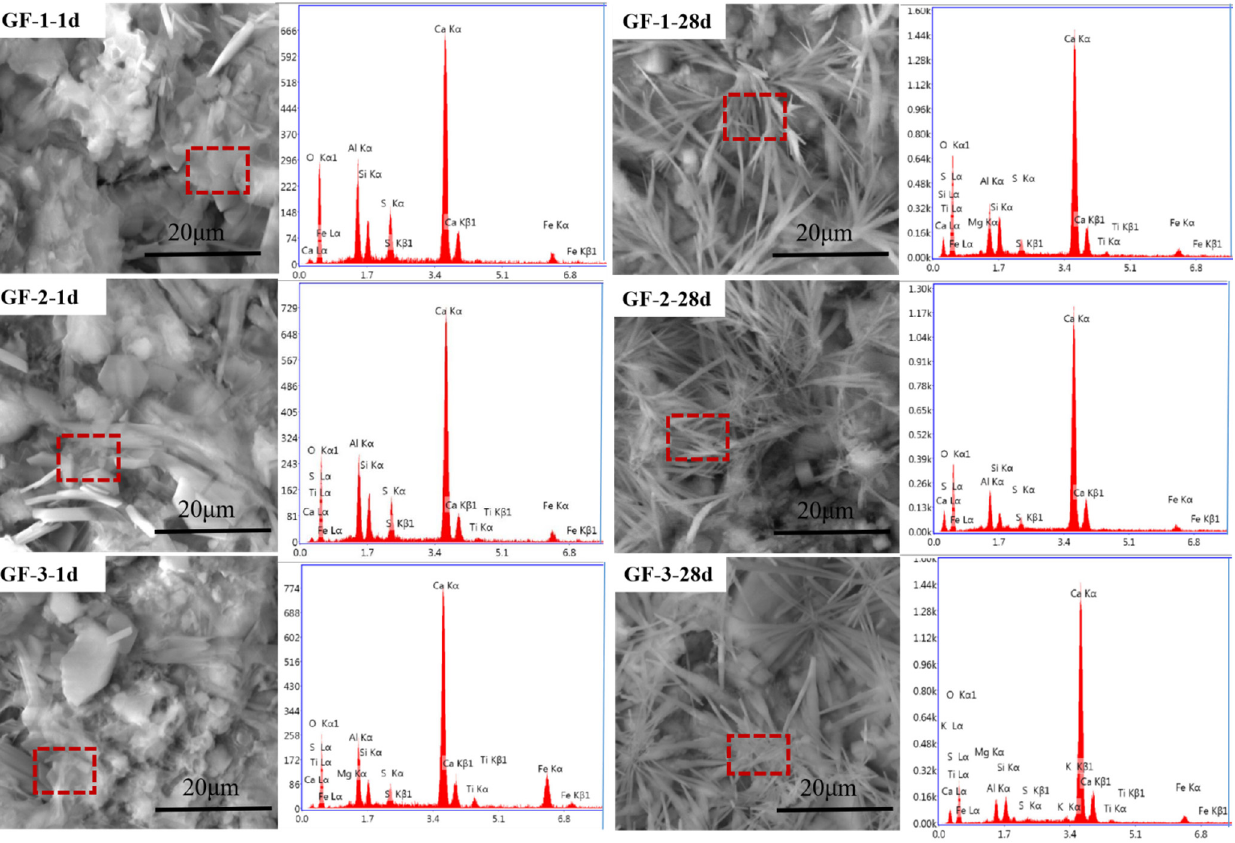
Table 7. The weight loss of the sample derived from the TG-DSC results (wt%).